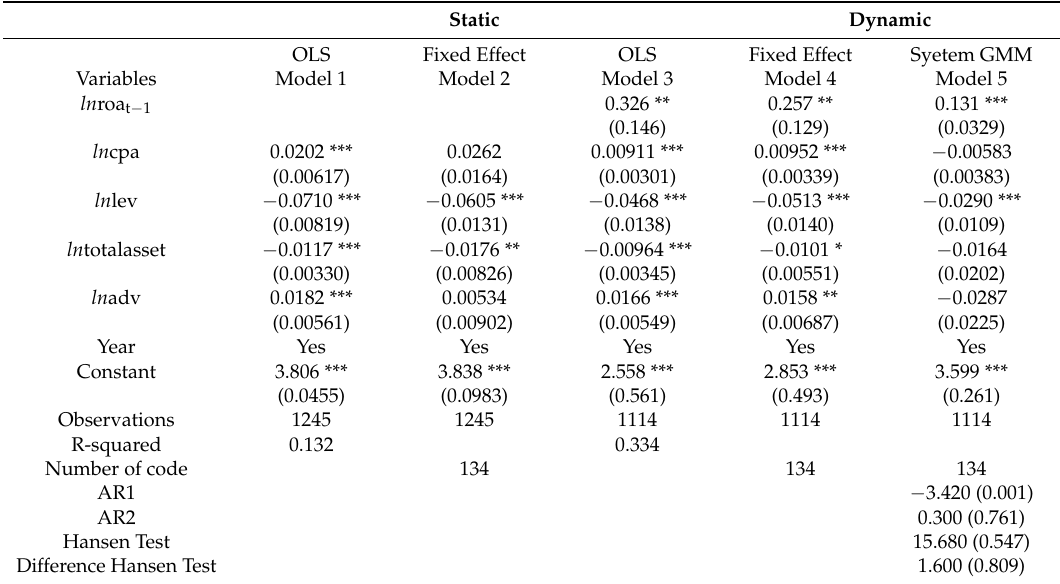
Table 3. Corporate lobbying and Corporate Financial Performance (CFP) (Return on Assets (ROA)) (N = 134 firms; T = 10; period =